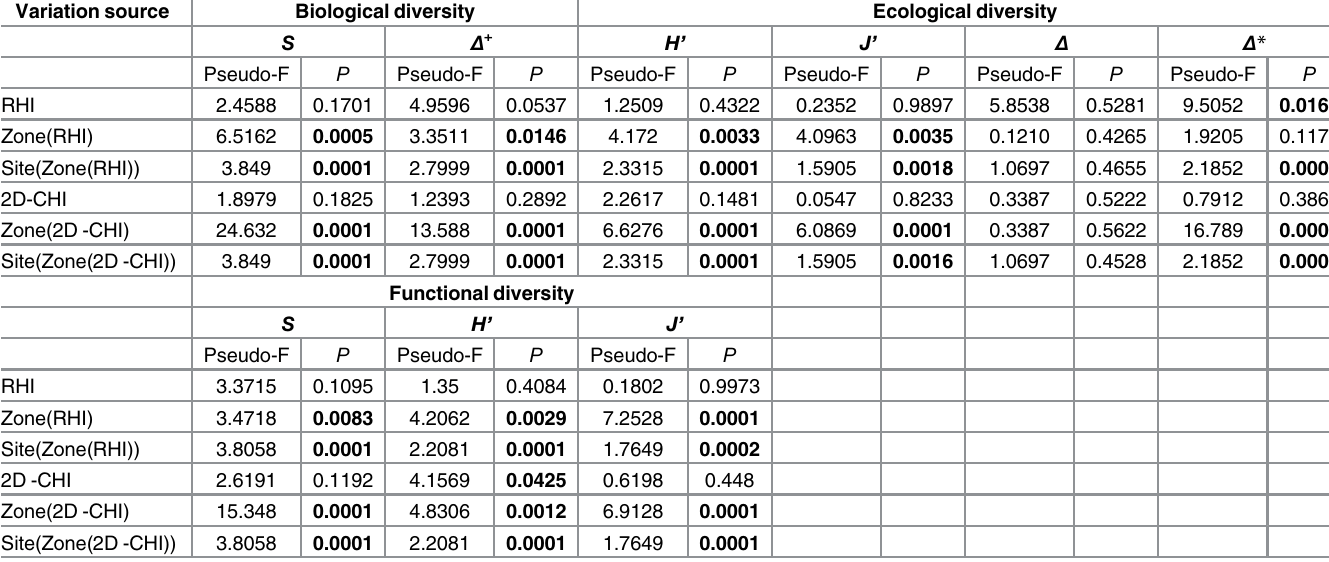
Table 3. Three-way fully nested and permutational ANOVAs outcomes contrasting biological, ecological and functional diversity of reef fish among different health grades of the RHI and 2D-CHI indices, among zones nested in health grades and among sites nested in zones and health grades.